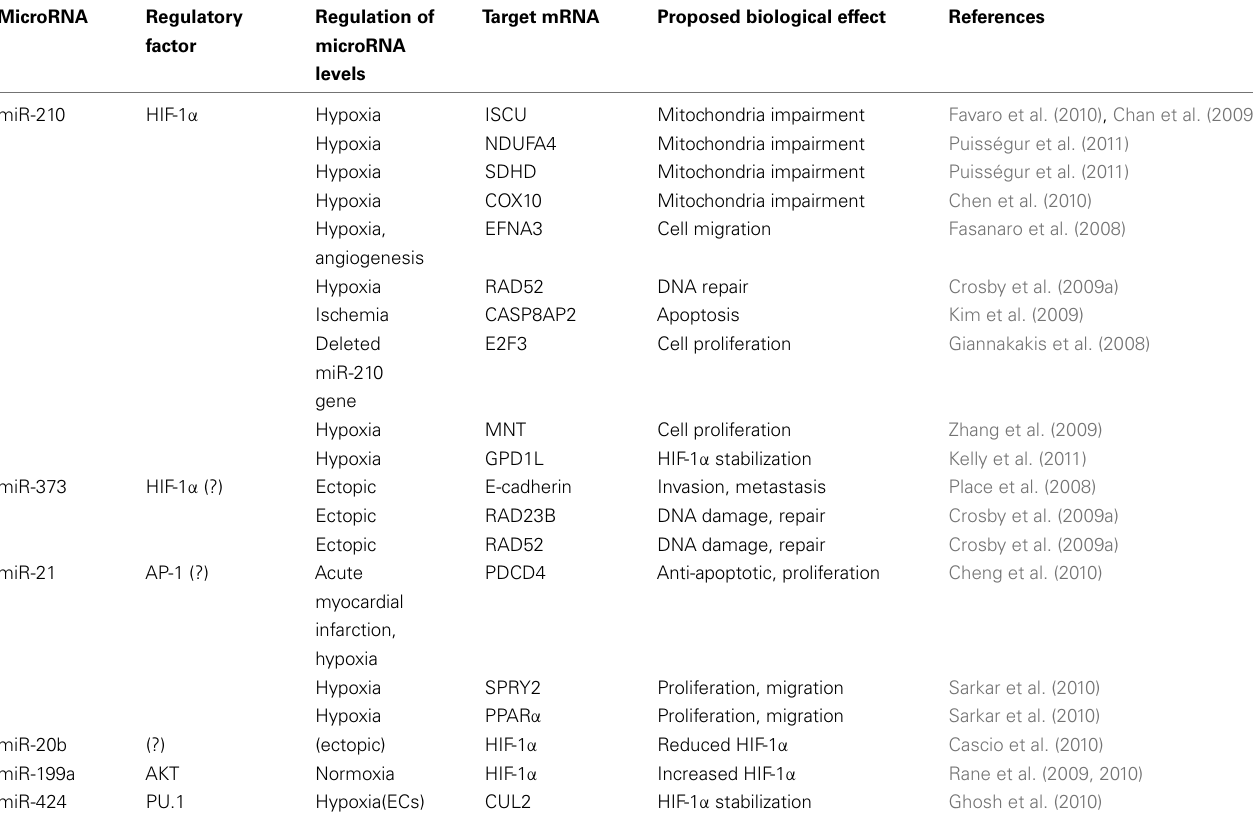
Table 2 | MicroRNAs implicated in the hypoxic